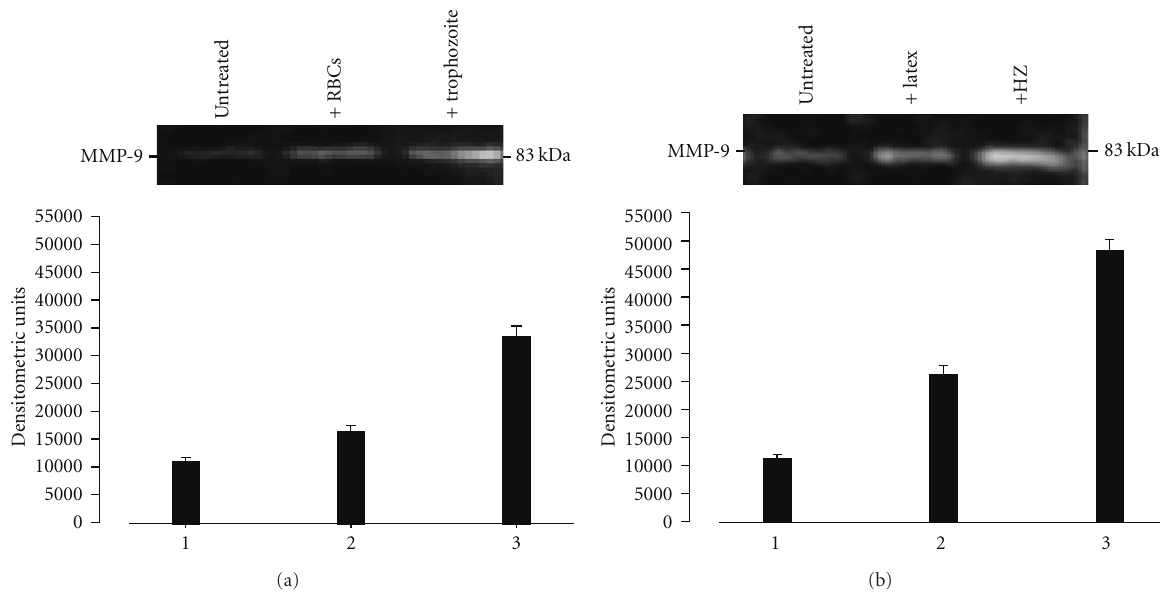
Figure 2: HZ-containing pRBCs (trophozoites) and free HZ enhance MMP-9 levels in HUVECs. Untreated cells (column/lane 1, both panels), cells treated with uninfected RBCs or latex as control stimuli (column/lane 2, (a) and (b) resp.), and cells treated with HZ- containing-trophozoites or HZ (column/lane 3, (a) and (b), resp.) were incubated for 48h. At the end of the treatment, MMP-9 levels were measured in HUVEC supernatants by SDS-PAGE gelatin zymography and densitometric analysis through a computerized densitometer as previously described [23, 24]. Column data (lower panels) are mean values of arbitrary densitometric units + SEM of three independent experiments; gel data (upper panels) are from one representative experiment; the 83-kDa negative bands in the gel indicate MMP-9 levels. Data were analyzed for significance by Student’s t -test and all di ff erences were significant ((a) 1 versus 2: P < . 02; 1 versus 3: P < . 001; 2 versus 3: P < . 002. (b) 1 versus 2: P < . 001; 1 versus 3: P < . 0001; 2 versus 3: P < .